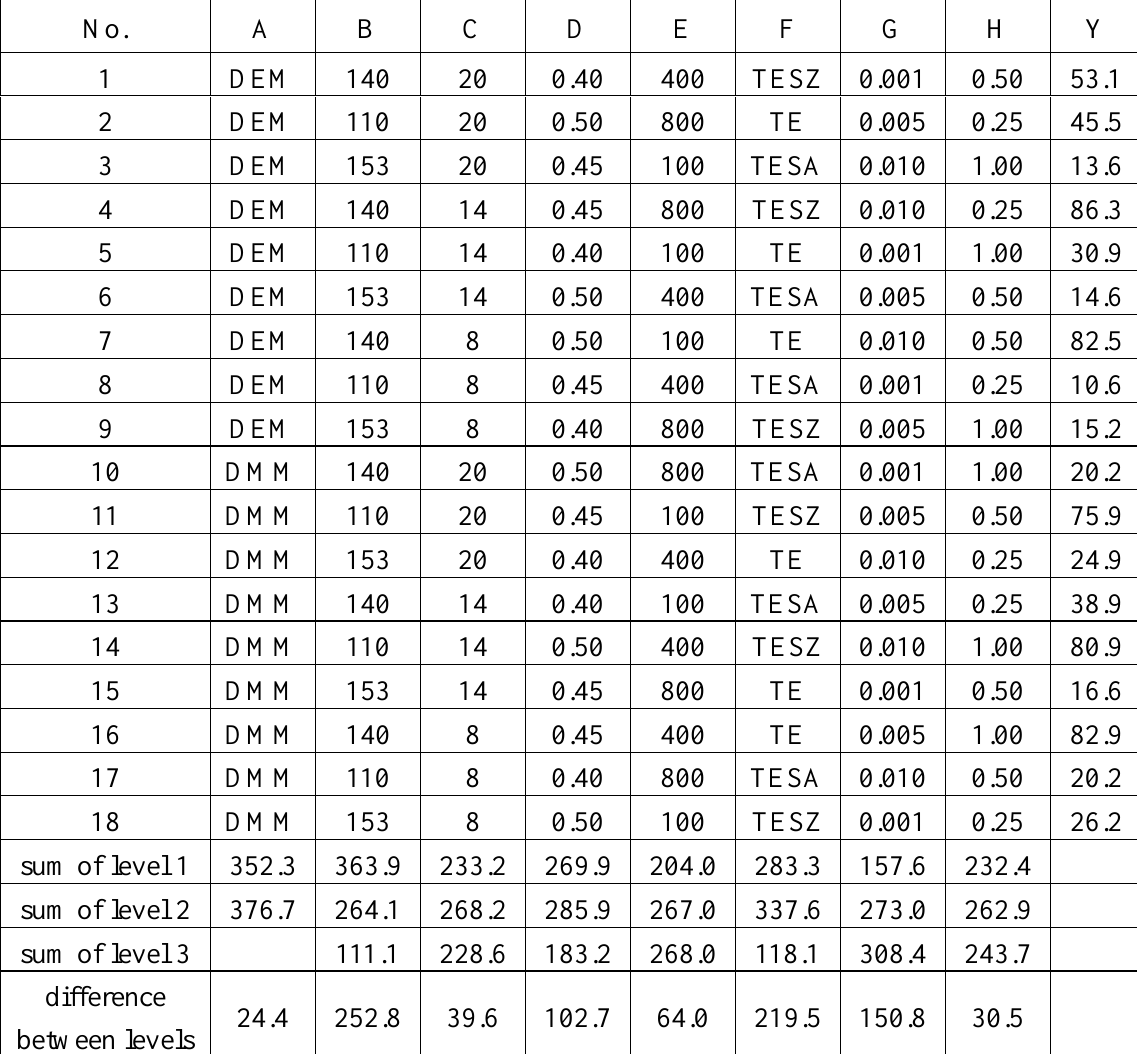
Table 2. The orthogonal design layout and the experimental results